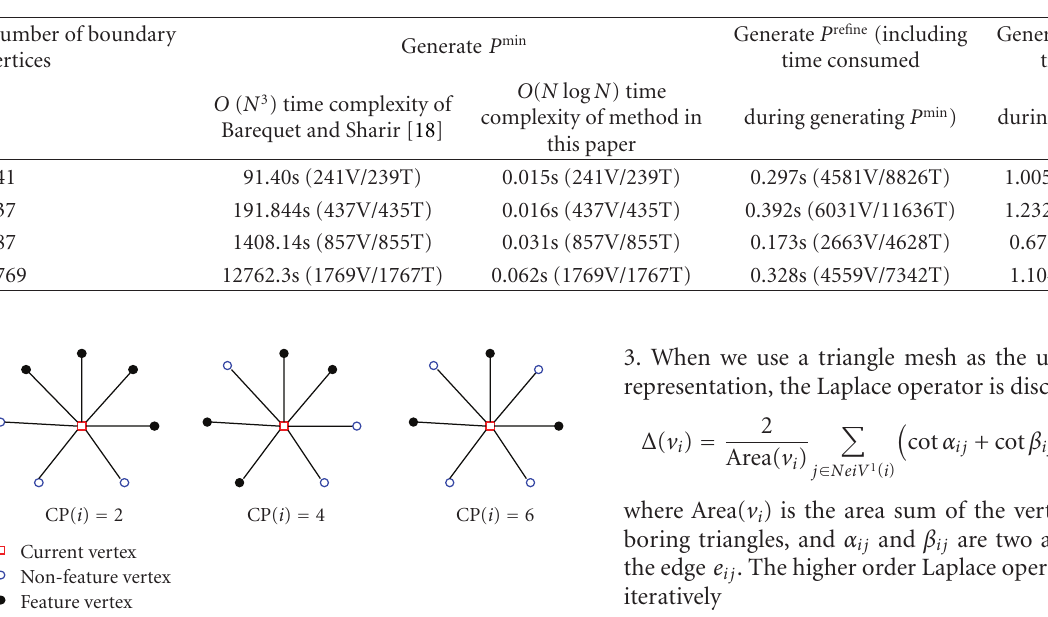
Figure 13: Examples of vertex’ complexity